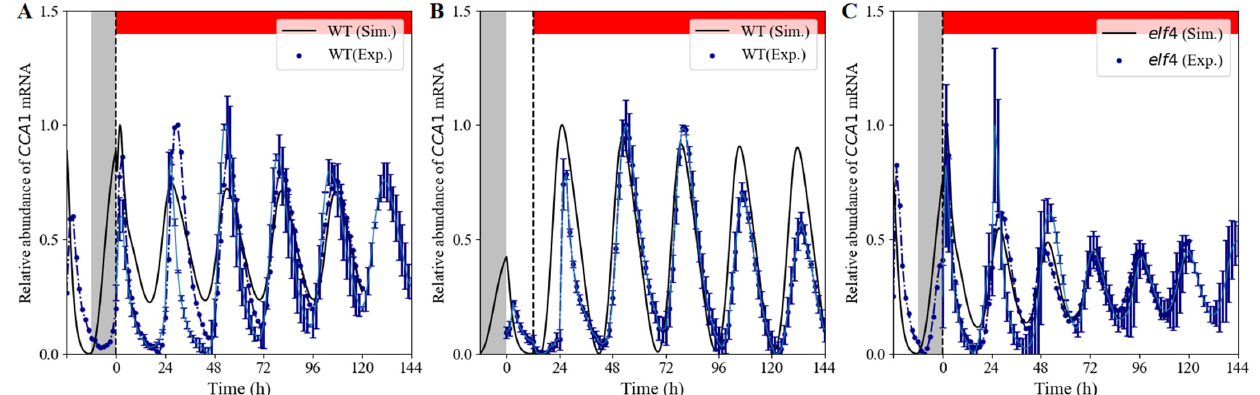
Figure 2. The expression profiles of the core circadian element CCA1 under constant red light (RR). Wild-type (WT) and mutant lines were entrained for 120 h under white-light/dark cycles. ( A ) The WT lines were transferred into RR at ZT0. ( B ) The WT lines were transferred into RR at ZT12. ( C ) The elf4 mutant lines were transferred into RR at ZT0. The basic parameters are shown in Supplementary Table S2. In the elf4 mutant simulation, the maximum synthesis rate in white light ( v 4 L ) and red light ( v 4 R ) of EL mRNA are respective 0.294 and 2.63 versus 1.47 and 6.1 in WT. The grey and red bars represent darkness and red-light treatment, respectively. The black solid lines and the blue circles indicate simulated expression (Sim.) and experimental data (Exp.), respectively. Transcript levels are means ± SD for n = 8~26 clusters of Arabidopsis plants in 3~6 biological